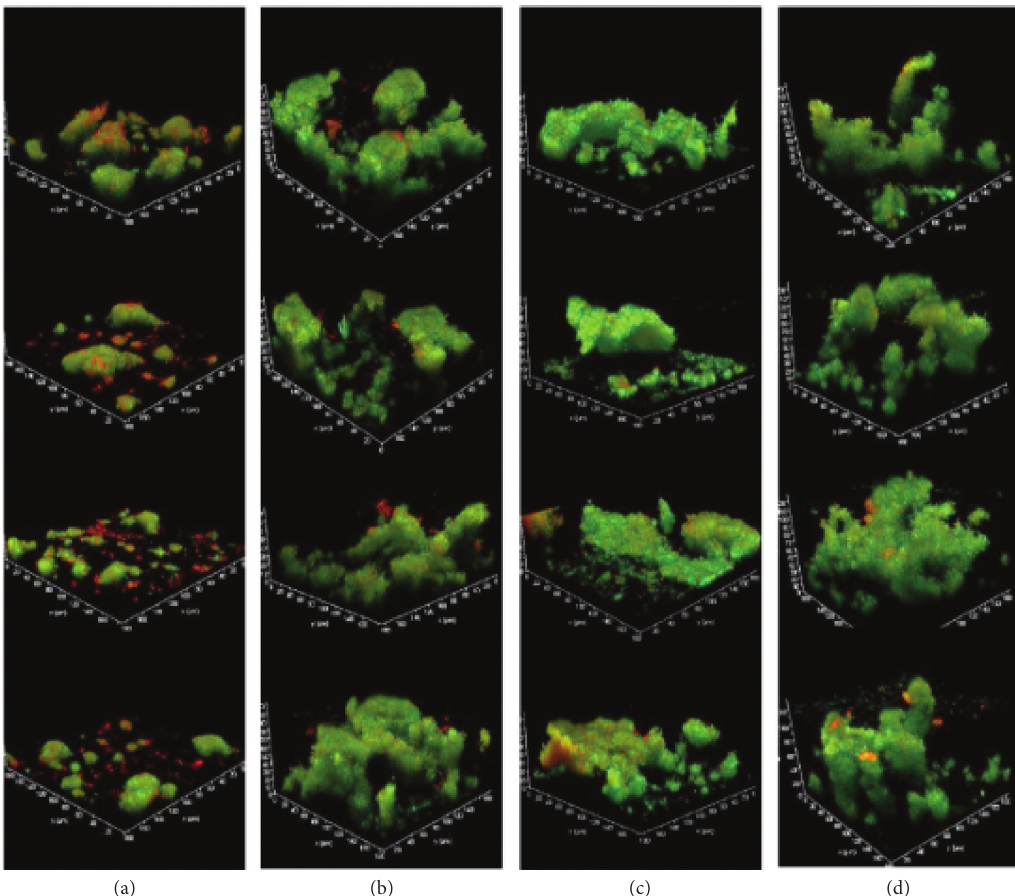
Figure 3: Three-dimensional confocal microscopy images (600x) from Streptococcus spp. biofilms grown on (a) CoCr, (b) Ultaire ® AKP, (c) PMMA, and (d) POM for 24 hours under dynamic conditions in the CDC Biofilm Reactor. Each panel shows multiple images from a single representative biofilm.